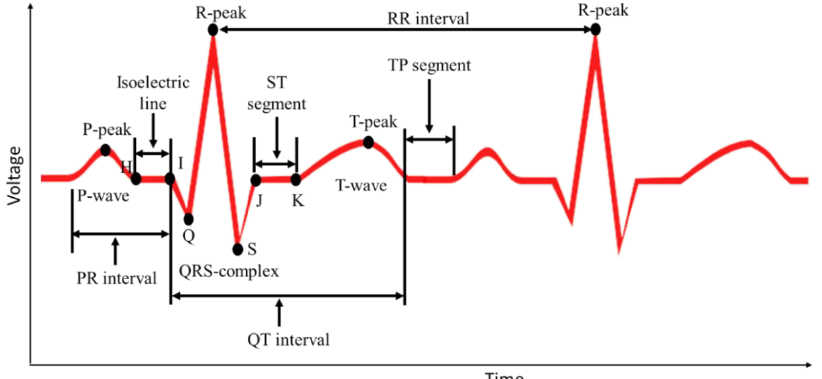
Figure 8. Normal ECG waveform with the waves and intervals. Note: user-defined HI line represents the isoelectric (ISO) line and JK line represents the ST segments.